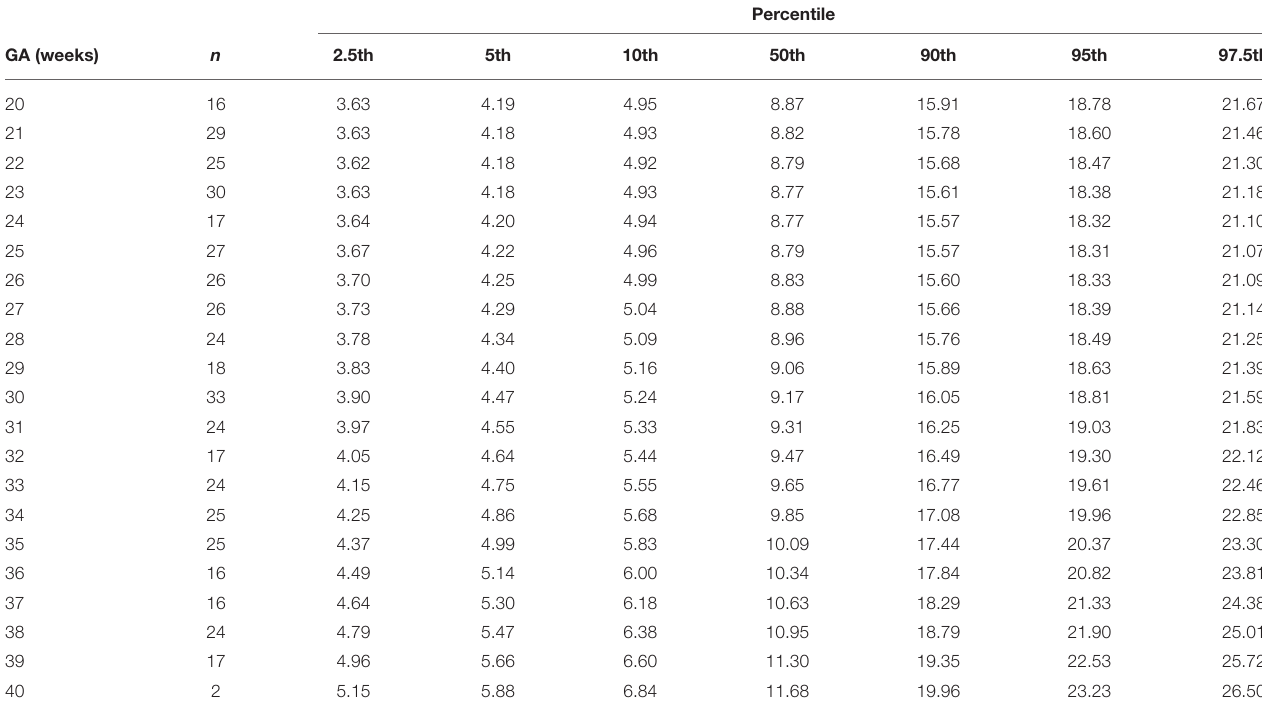
TABLE 11 | Percentiles of fetal superior vena cava volume blood flow as the fraction of combined ventricular cardiac output at 20–40 weeks of gestational age (GA).